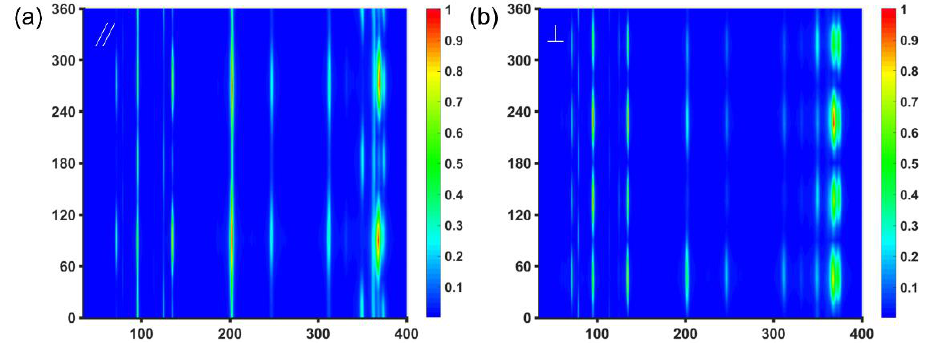
Figure 6. False-color plots of polarized Raman intensities under parallel ( a ) and perpendicular ( b ) polarization configurations.